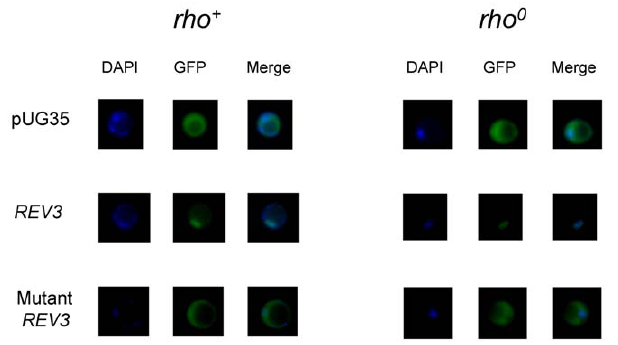
Figure 9. Localization of Rev3. Localization of Rev3 and mutagen- ized Rev3 fused with EGFP in (A) a rho + strain and in (B) a rho 0 strain. Images have been acquired and adjusted as reported in Materials and Methods. In rho + strain DAPI stains both the nuclear DNA (bigger spot) and the mtDNA (small spots in the cell periphery). In rho 0 strain, which is depleted of mtDNA, DAPI stains the nuclear DNA only.